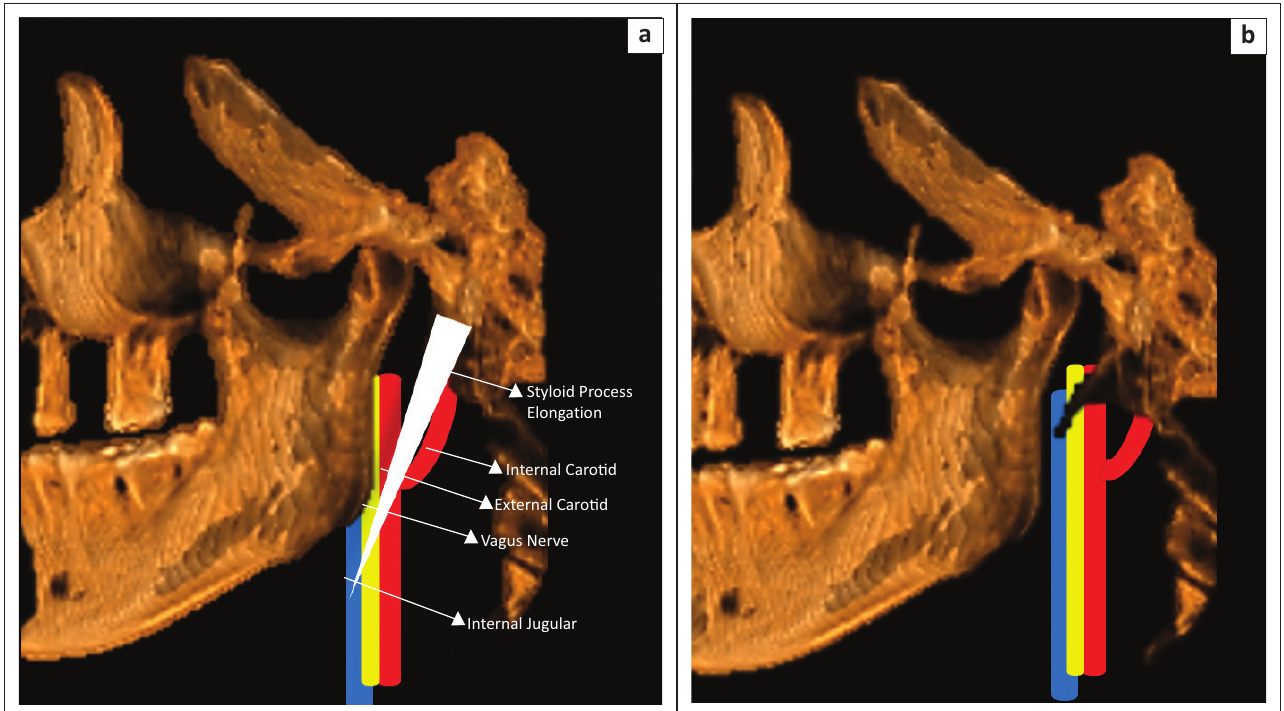
FIGURE 1: Schematic representation of (a) elongated styloid process causing impingement on vital structures versus (b) normal styloid process.